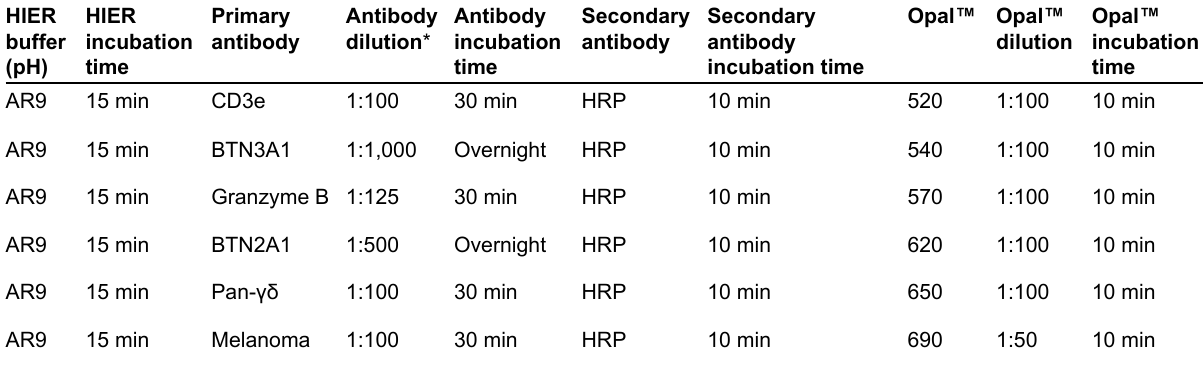
Table 3. Staining conditions for panel 2 (melanoma tissue)